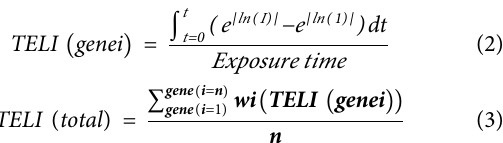
FIGURE1| Survivalof E.coli (averagevalues)atdifferentconcentrations of SUC.